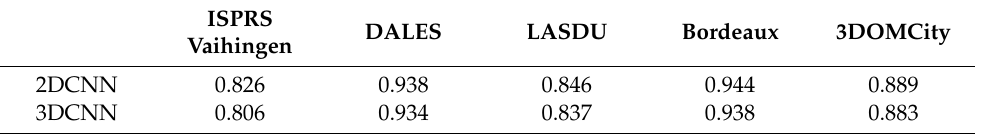
Table 21. Summarized OA achieved in the different datasets considered in the evaluation procedures.